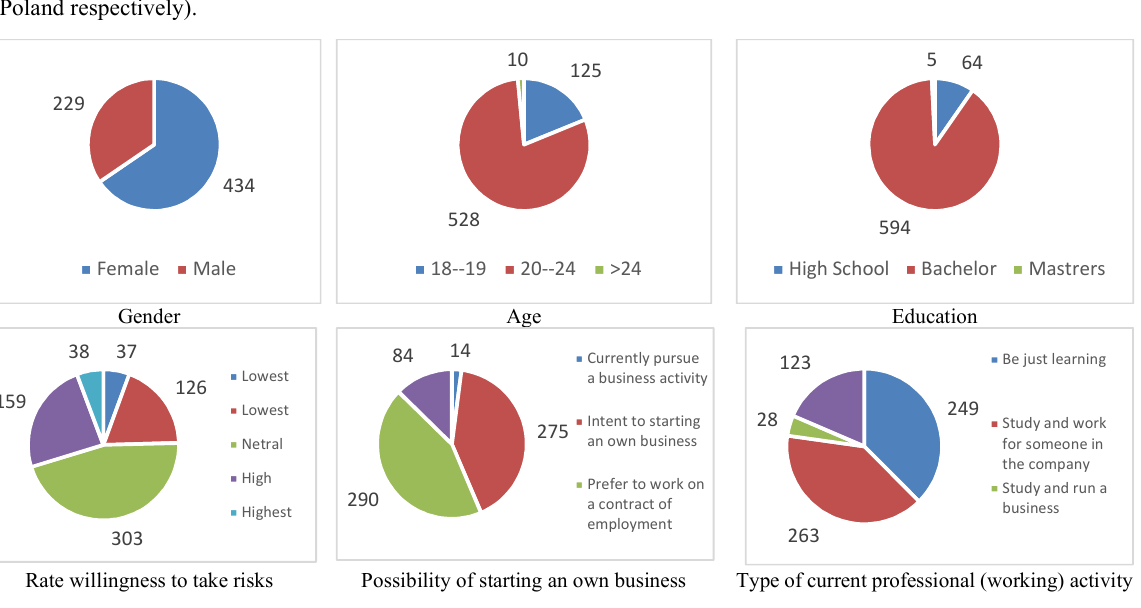
Fig. 1. Demographical information and some other information related to entrepreneurial intention of samples Note: